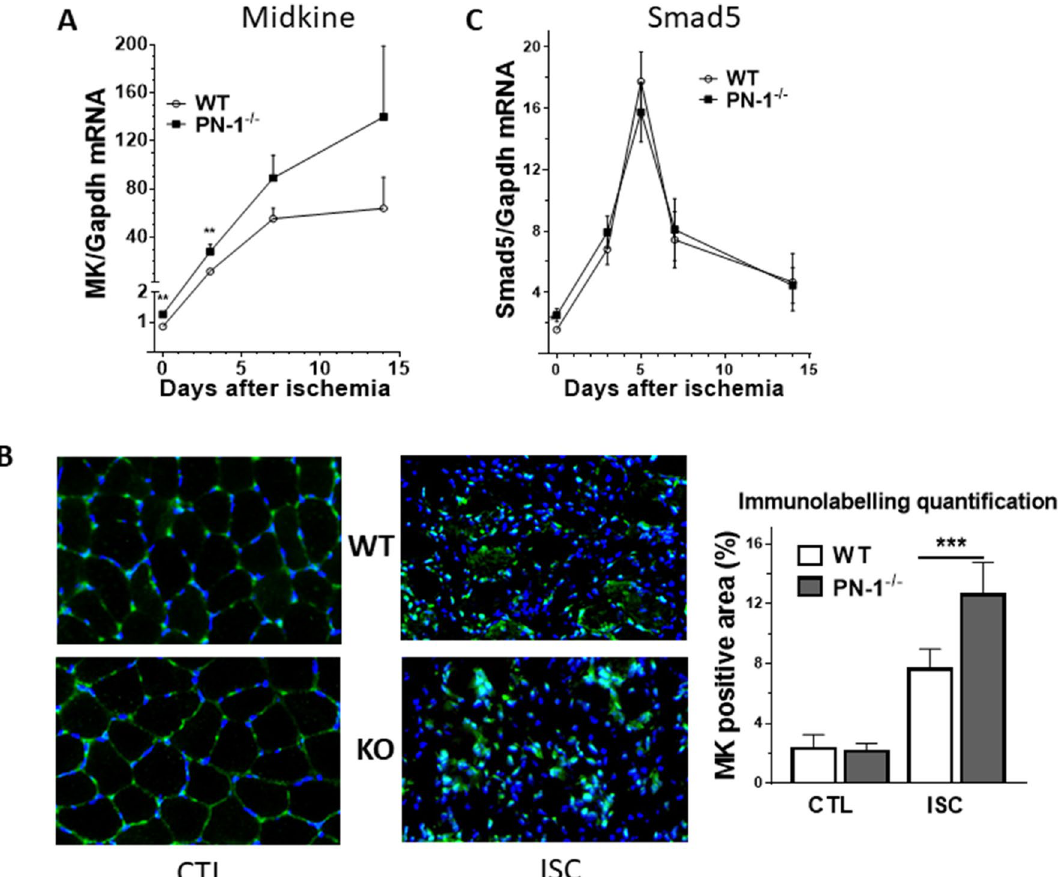
Figure 5. Midkine expression level is increased in PN-1-deficient mice, in control conditions and after ischemia, ( A ) Expression kinetics of Midkine mRNA following ischemia; Mann Whitney analysis. ( B ) Midkine immunolabelling (midkine in green, DAPI in blue) of gastrocnemius frozen sections (CTL) and 3 days after ischemia (ISC). Mann Whitney ** p < 0.01. Representative images and quantification are shown (n = 4). Anova, *** p < 0.001. ( C ) Expression kinetics of Smad5 mRNA following